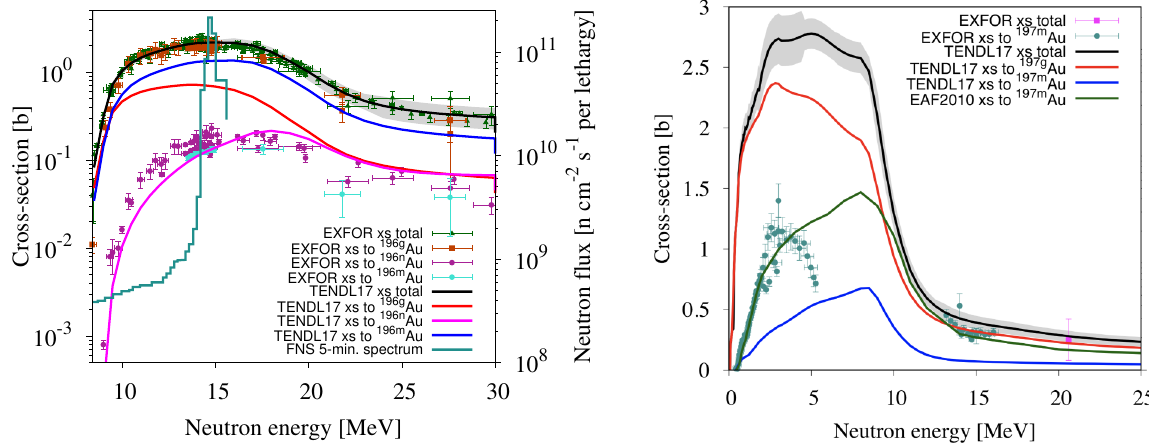
Figure 2: Comparison of evaluated cross-section for 197 Au(n,2n) reaction channel (left) and 197 Au(n,n (cid:48) ) reaction channel (right) along with the EXFOR experimental data. Table 1: Details of the investigated reaction pathways for gold,